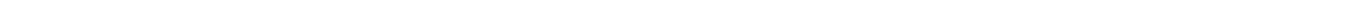
Fig. 2 Lentiviral CREB in peri-infarct motor enhances motor recovery. a Experimental timeline of behavioral studies. TAM taxomifen. b , d , f Gridwalking tasks of forelimb function in gait. Y axis is percentage of footfaults of the right (affected) forelimb contralateral to the stroke. c , e , g Pasta handling task of distal forelimb function. Y axis is the percentage of left forelimb adjustments (unaffected forepaw) relative to right forepaw (affected forepaw). b , c CREB gain of function. Stroke + CREB induction in motor cortex produced a signi fi cant recovery in forelimb function compared with stroke + Control virus (*** p < 0.005) over 3 – 4 weeks after stroke, respectively in pasta handling adjustments and gridwalking. d, e Stroke + CREB induction in posterior parietal cortex did not produce recovery in forelimb function either in gridwalking or pasta handling over 8 weeks after stroke. f, g CREB loss of function. Activating CREB IR with TAM 6 h before behavioral testing (stroke + TAM) reduces motor control and blocks the pattern of motor recovery seen in stroke alone (Stroke + Saline). * P < 0.05, ** P < 0.01, *** P < 0.005. Error bars are SEM. Statistics are two way ANOVA followed by Bonferroni post hoc test. n = 8 for control